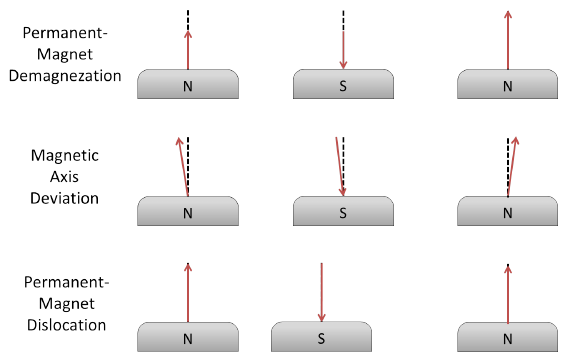
Figure 7. Permanent-magnet defects: demagnetization, magnetic axis deviation and dislocation.